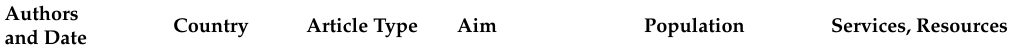
Table 1. Summary table of identified